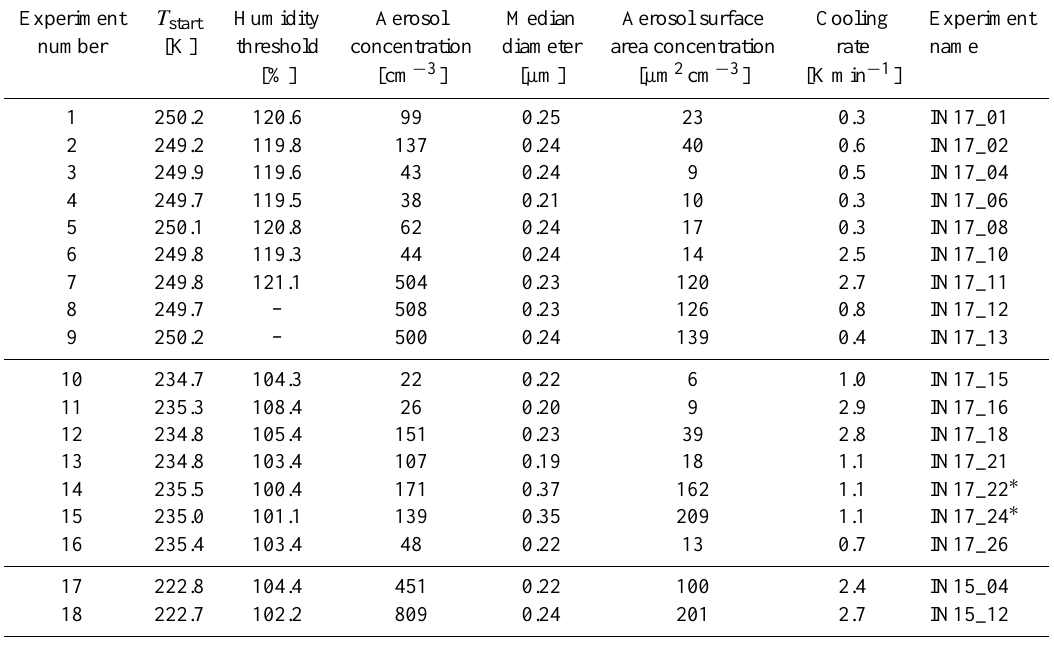
Table 1. Overview of ice nucleation experiments with ATD as carried out at the AIDA cloud chamber; reference experiments (without ATD particles) being omitted – experiments not employing cyclone impactor stages are marked by an asterisk; experiments are grouped according to the temperatures at the beginning of each individual run.